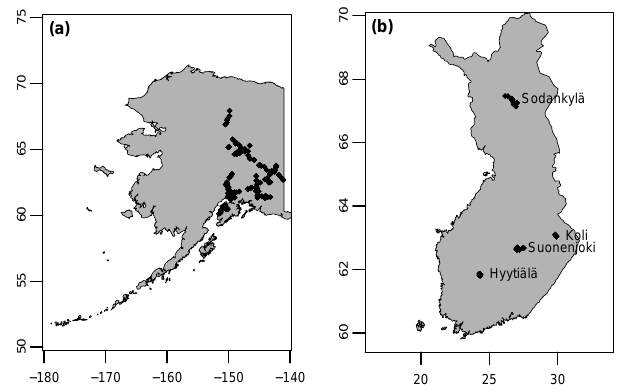
Figure 1. Location of the field plots.